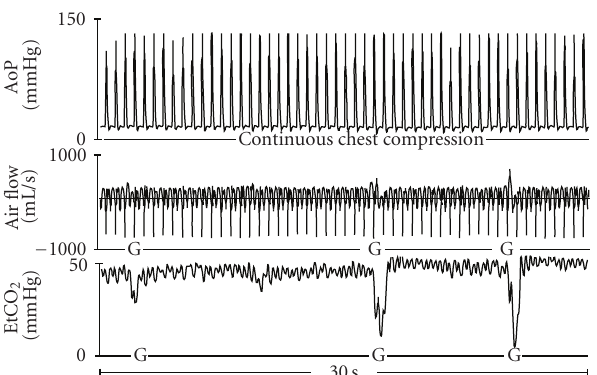
Figure 1: Graphic recordings of aortic pressure (AoP), air flow, and end-tidal CO 2 (EtCO 2 ) of a swine in the continuous chest compression (CCC) group. G marks a gasp.